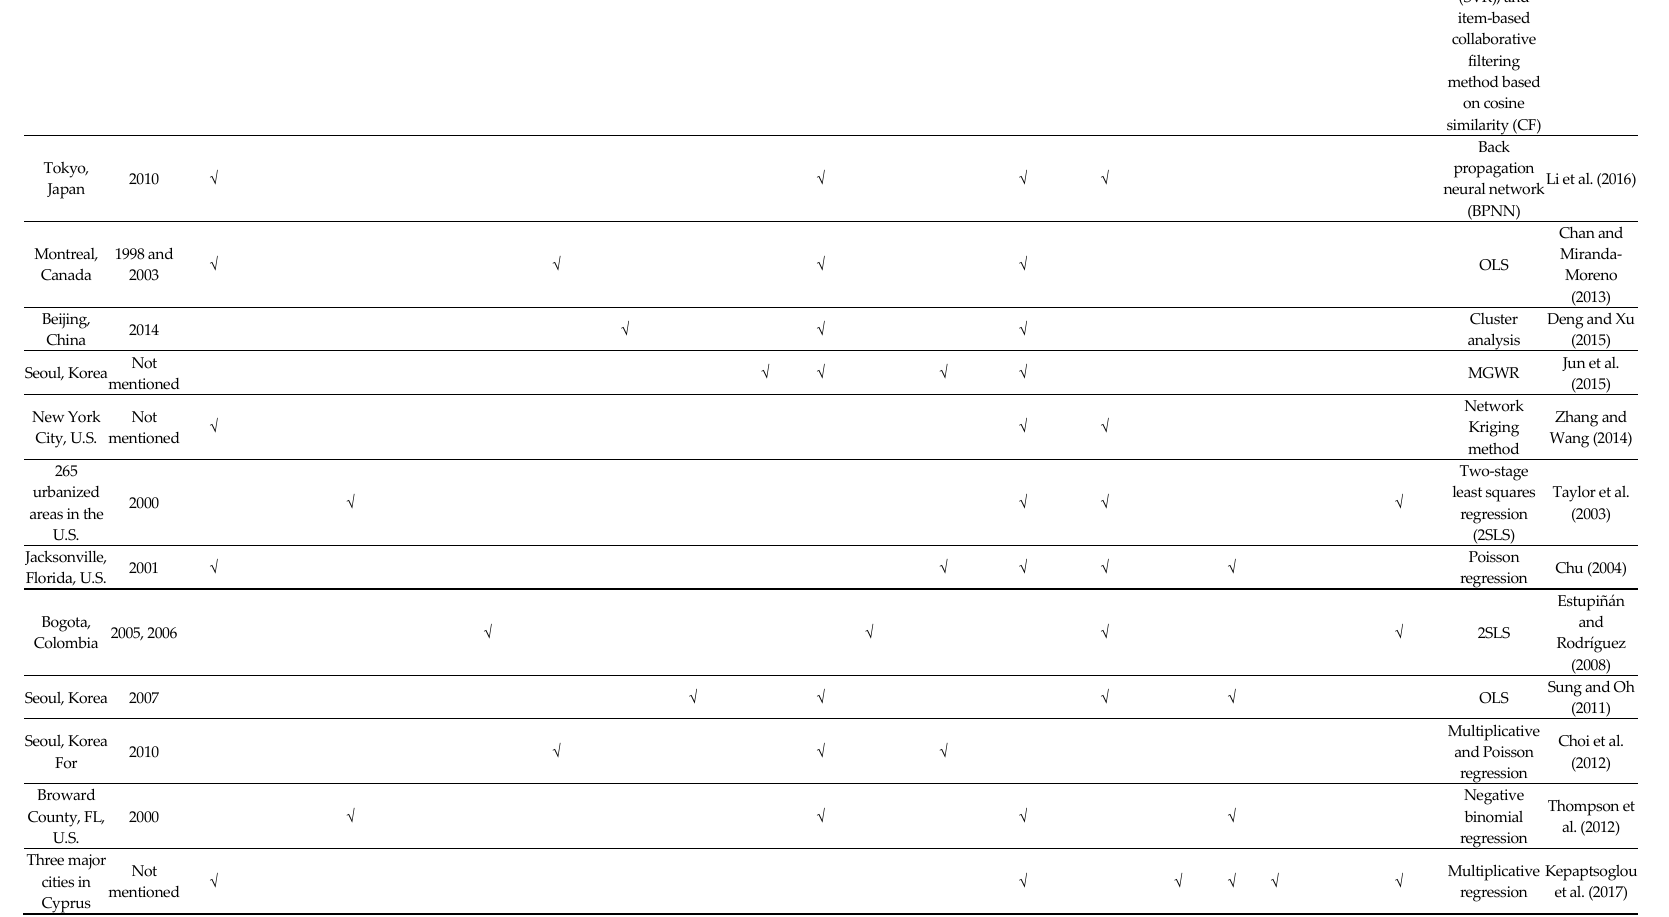
Table 1. Cont. Appl. Sci. 2019 , 9 , x FOR PEER